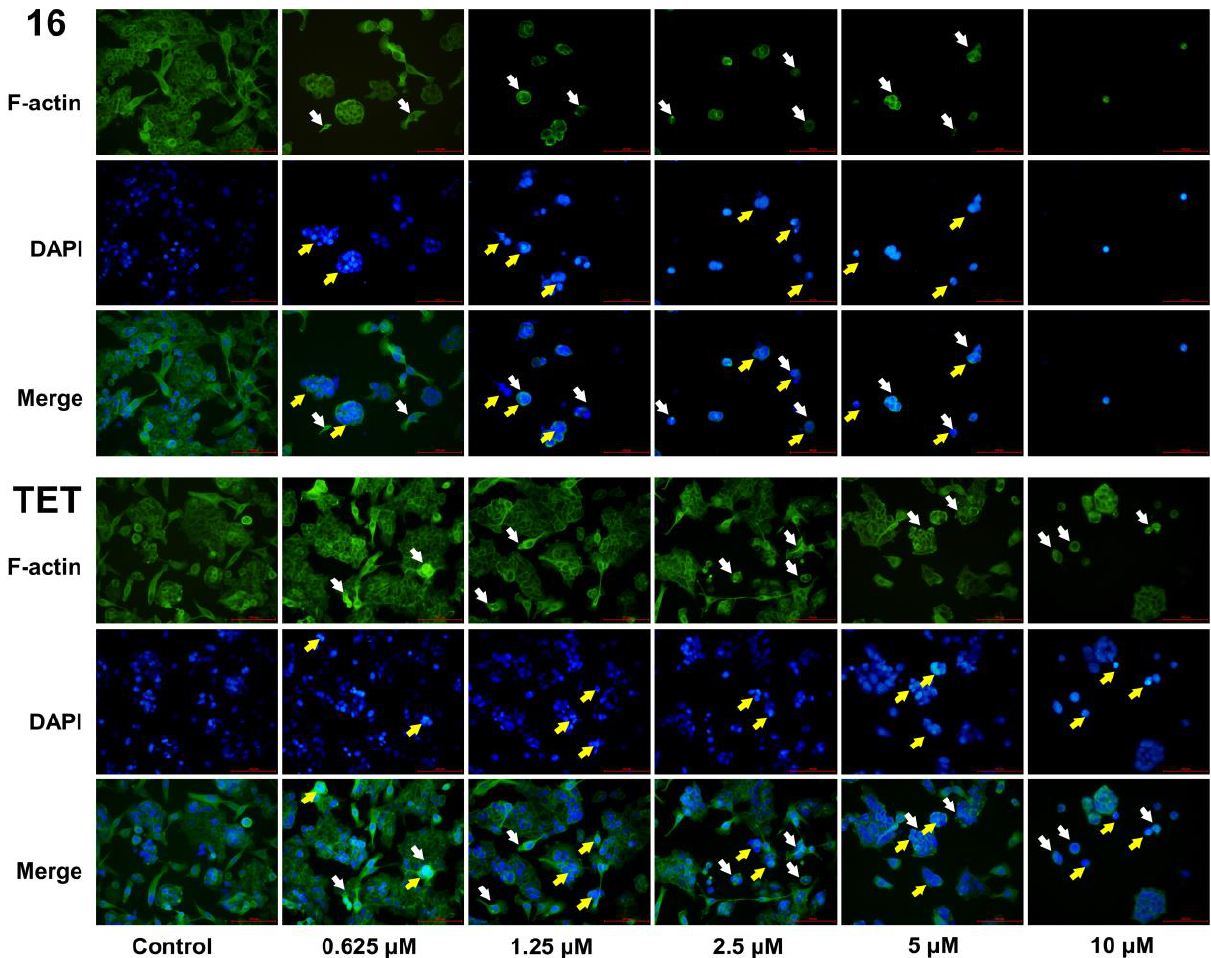
Figure 6. Morphological analysis of HCT-15 cells treated with 16 (0.625, 1.25, 2.5, 5, and 10 μM ). F-actin proteins and nuclei were stained with FITC-phalloidin (green) and DAPI (blue), respectively. White arrows represent cytoskeleton disruption and yellow arrows nuclear damage.